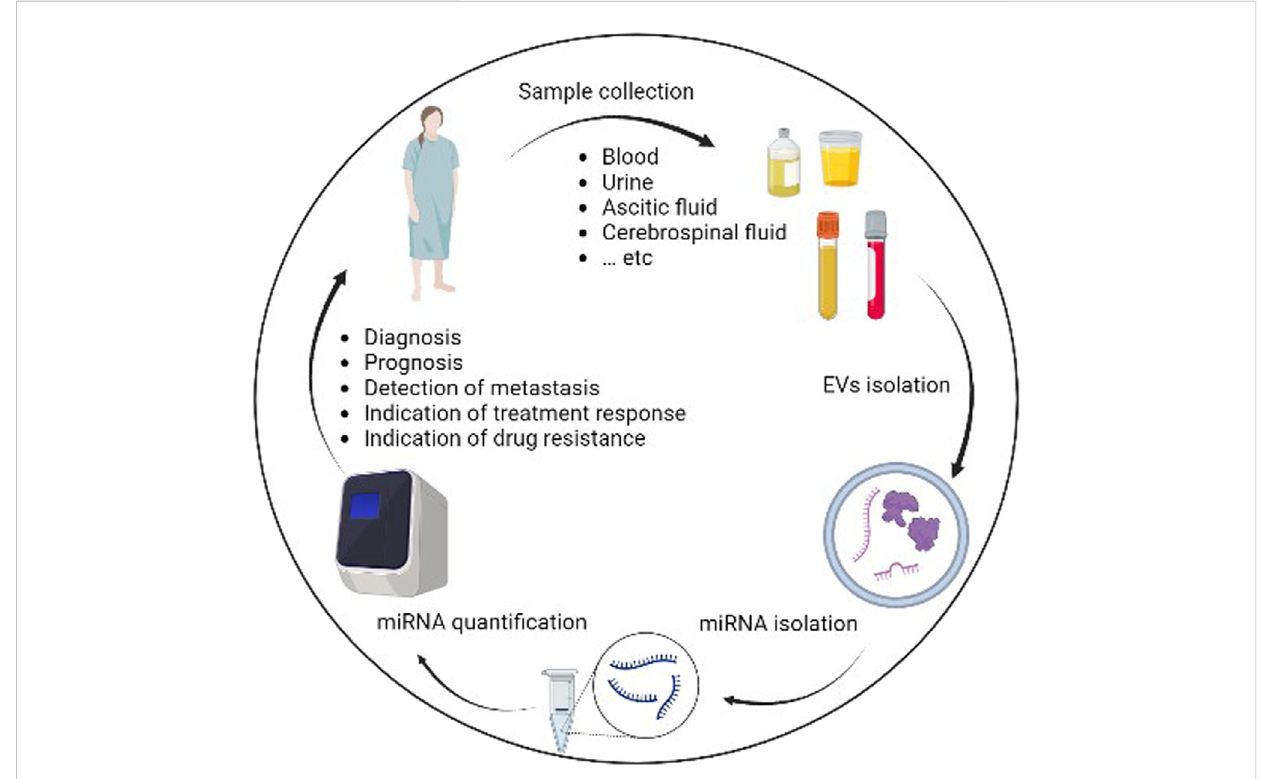
FIGURE 1 Work fl ow of processing and utilization of exomiRs for cancer clinical